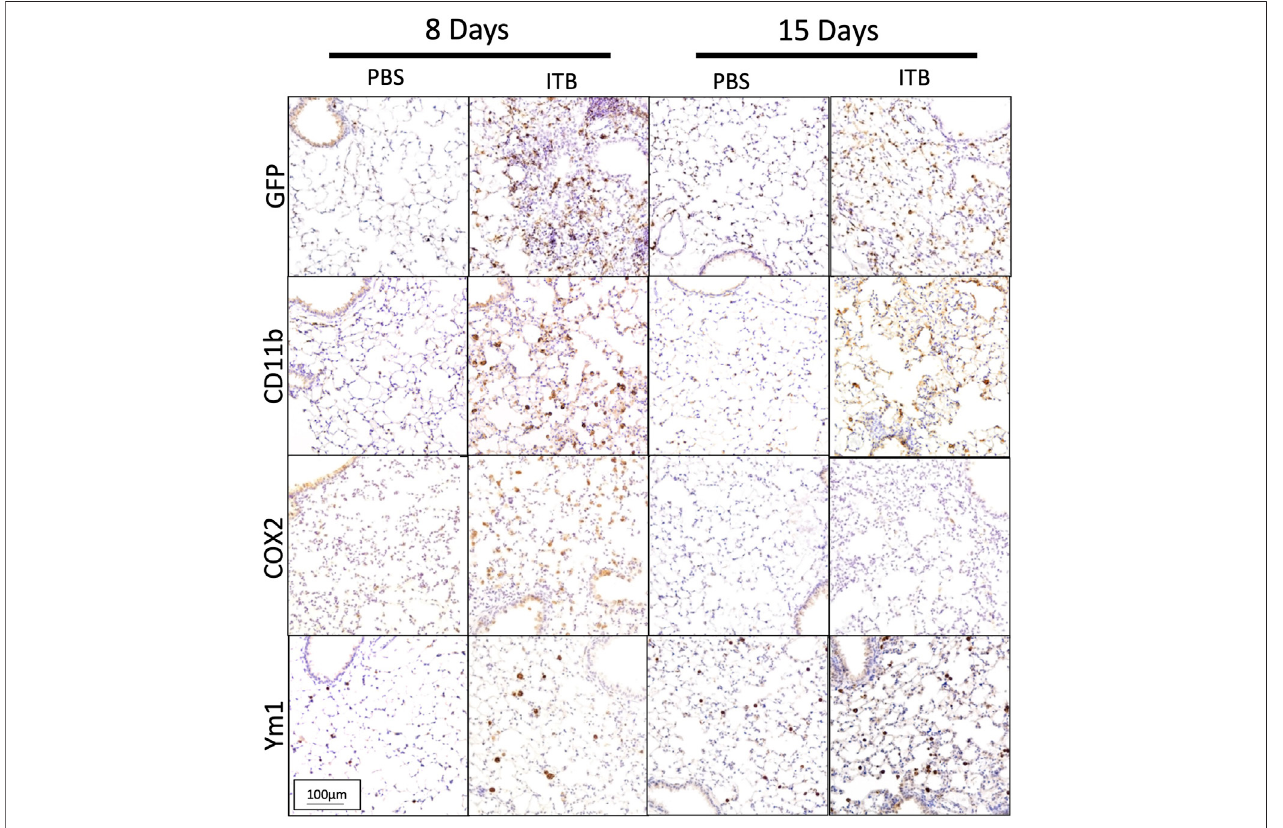
FIGURE6 | Macrophages arerecruitedand activated in lung. Lungspost lavage are assessed histologically for macrophage recruitmentand activation. (A) Lungs collected from PBS and bleomycin instilled mice are stained for GFP, CD11b, COX2, and Ym1. Representative pictures are at 200x. ( n = 4 – 7 mice per group)